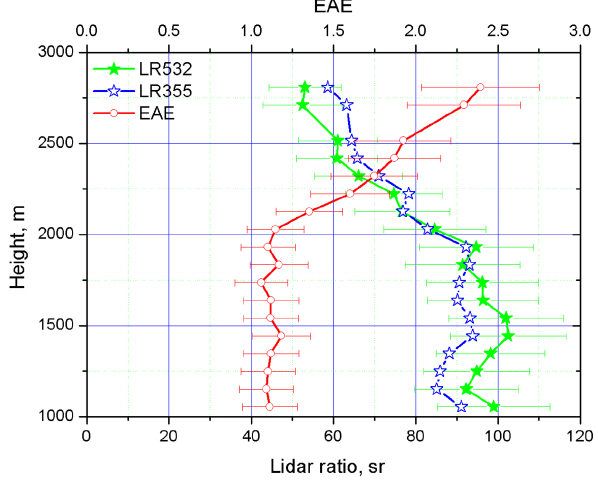
Figure 12. The profiles of effective radius and the real part of the refractive index derived from 3 β + 2 α measurements on 1 July